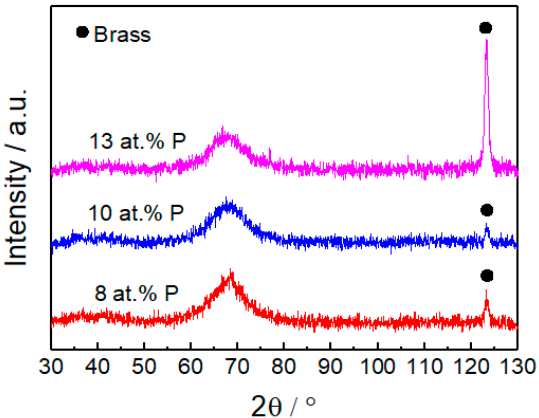
Figure 5. X-ray di ff ractograms of the Fe-W-P coatings deposited with increasing P content.